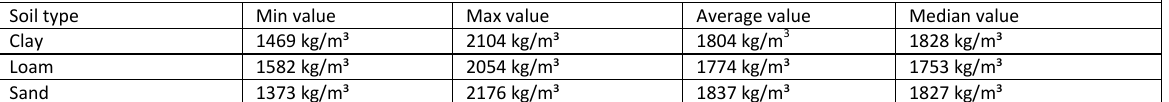
Table 1. Typical hydro ‐ mechanical properties of the soil mix material used for the construction of retaining walls – data from the BBRI Soil Mix project (2009 ‐ 2013) [12, 18]. Density of the soil mix material according to NBN EN 12390 ‐ 7 – data based on 1074 test results obtained on cylindrical core samples (Height H = Diameter D = 10 cm) from 38 job